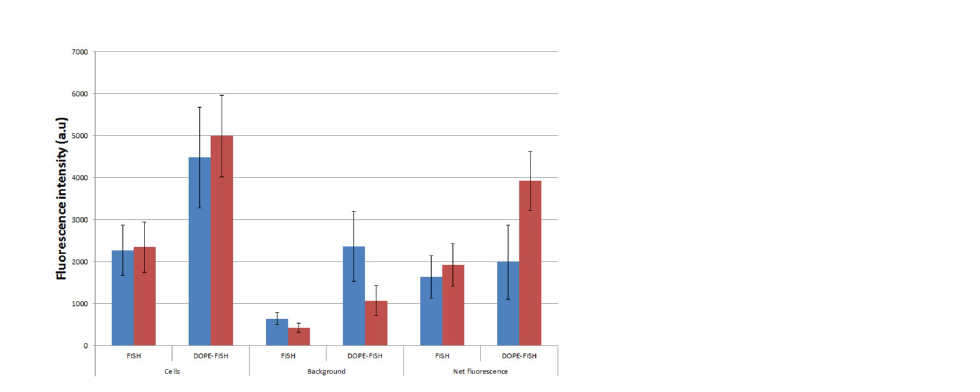
Figure 3. Comparison of FISH and DOPE-FISH mean fluorescence intensity of cells, background and net fluorescence efficiencies in E. coli . Hybridizations were carried out with FISH buffer (blue) or geneFISH buffer with pre-hybridization step